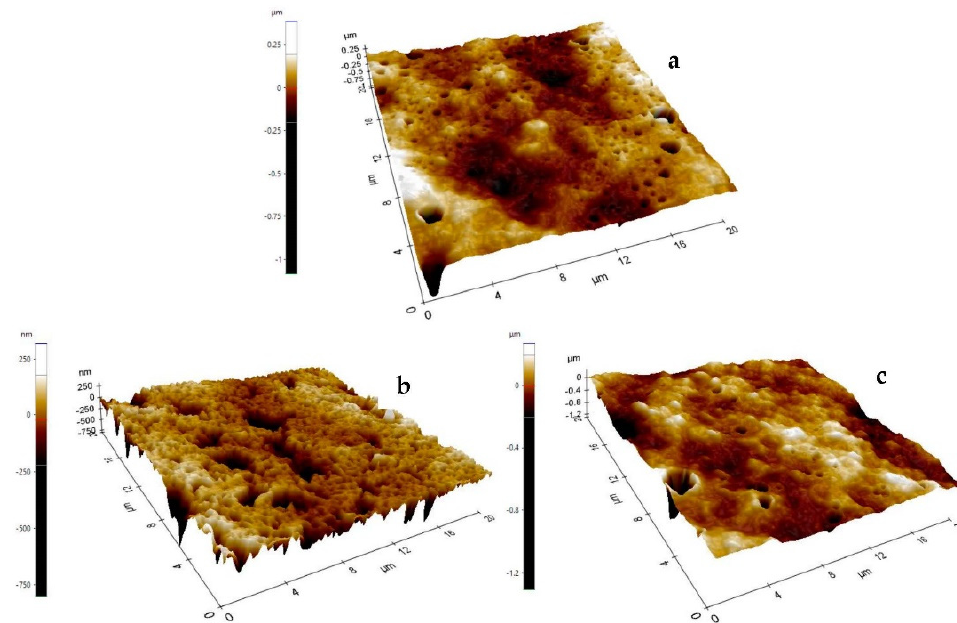
Figure 4. Atomic force micrograph of active edible films 4:1 (amaranth protein isolate:chitosan, w / w ) ( a ) without additions; ( b ) added with emulsified oregano essential oil; ( c ) added with mesoporous silica nanoparticles loaded with oregano essential oil.